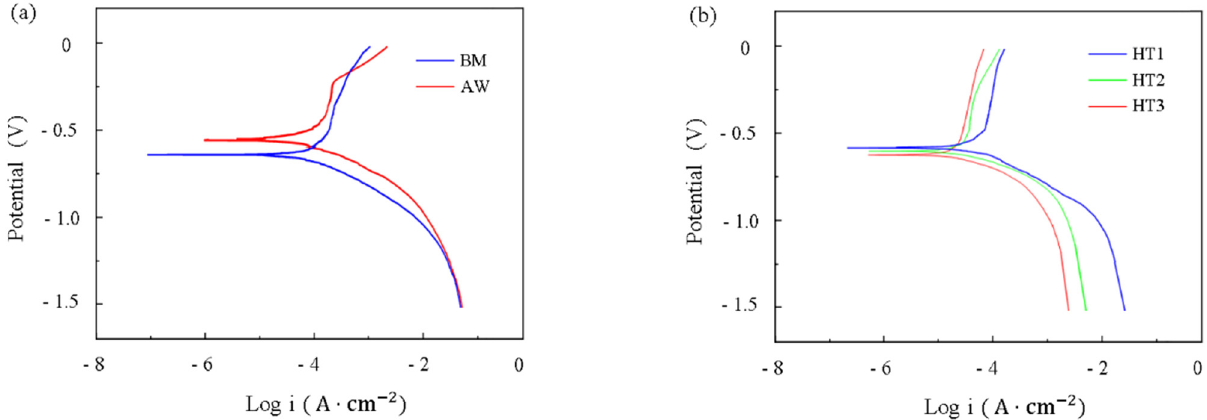
Figure 10: Tafel curves of di ff erent samples: ( a ) AW joint and BM and ( b )